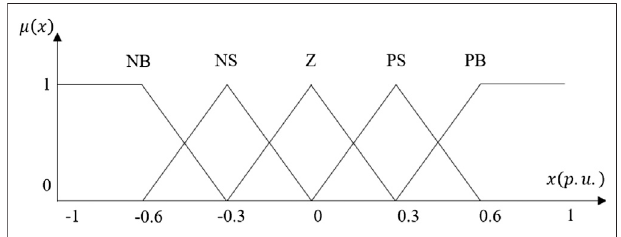
FIGURE 2 | 5-level membership function of the